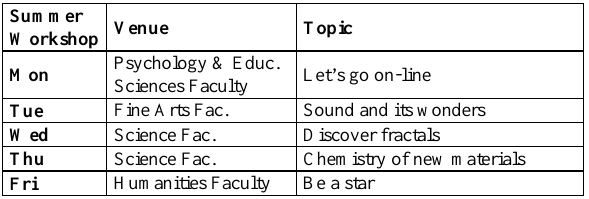
TABLE II. S UMMER W ORKSHOPS SAMPLE WEEK PROGRAM ( ONE OF SIX )